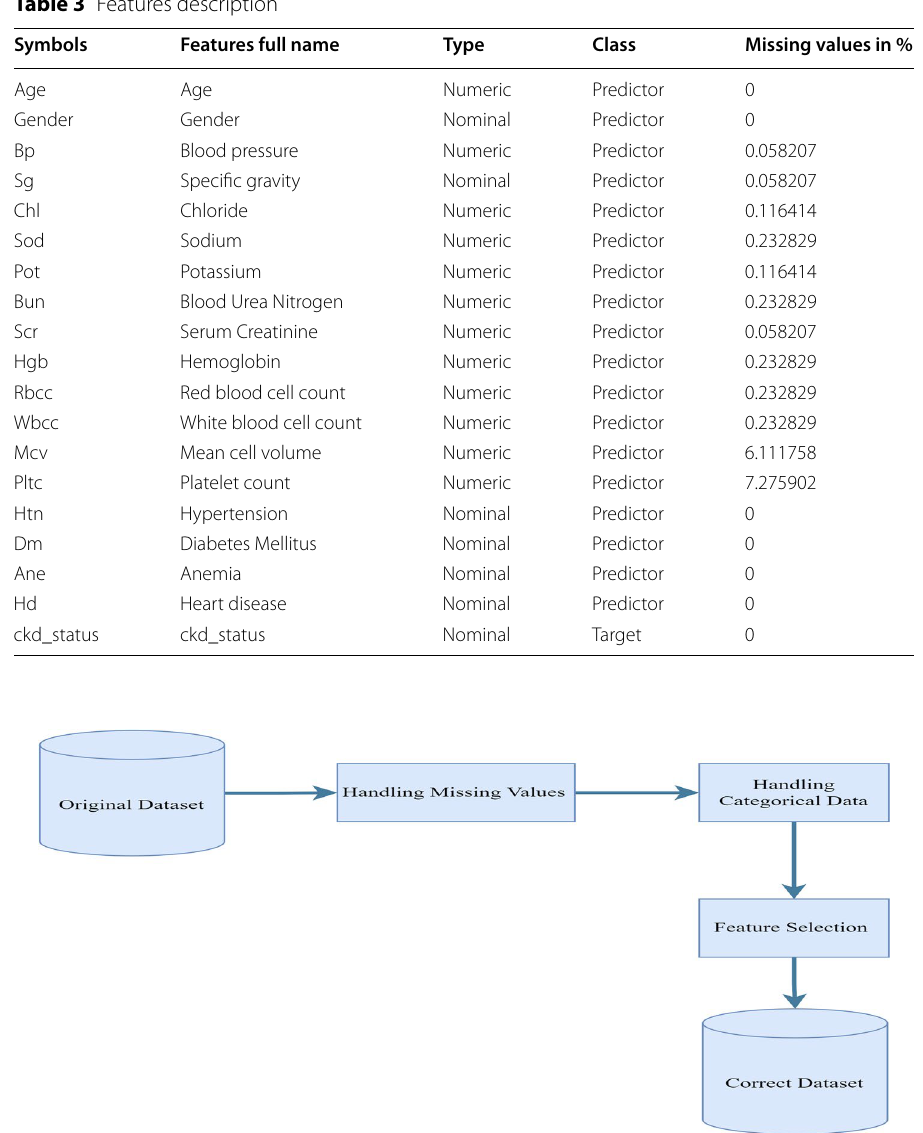
Fig. 1 Chronic kidney disease dataset preprocessing